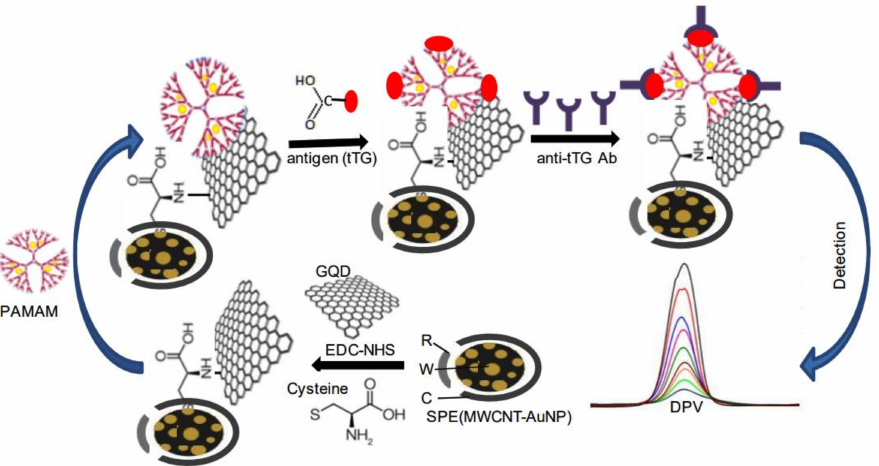
Figure 7. Diagrammatic representation of the biosensor based on DPV and CV to detect anti-tTG in the human celiac disease. Reproduced from Reference [64] with permission. Copyright 2017,